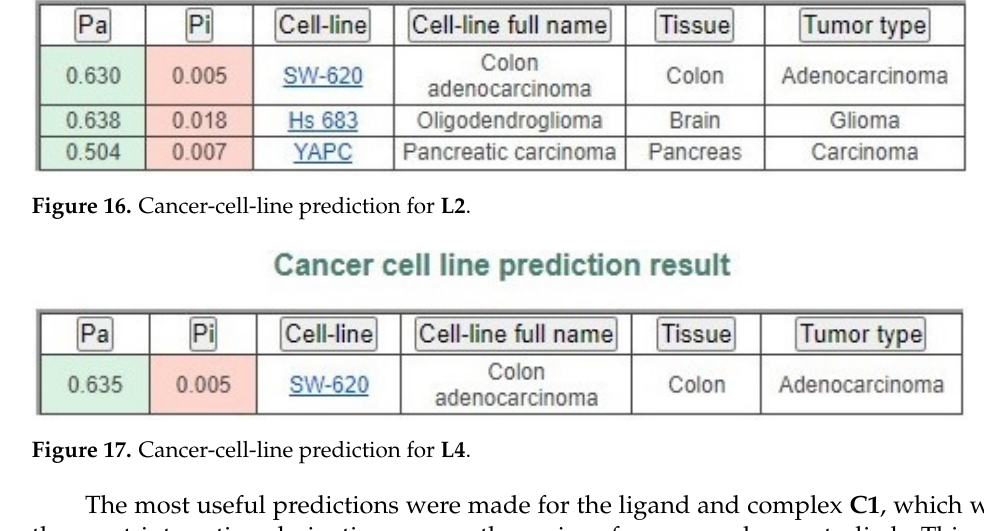
Figure 15. Cancer-cell-line prediction for L1 .